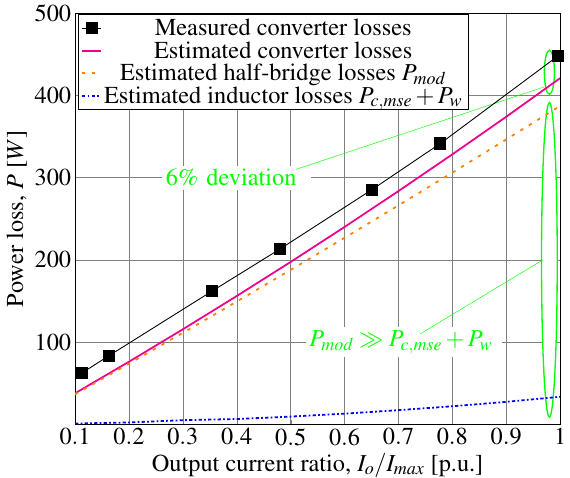
Figure 10. Power loss distribution of the converter for a fixed switching frequency of 20 kHz. It is necessary to ensure an inductance at the maximum current for a specified current ripple for powder core design. The maximum current ripple for this study is approximately 31.2 A with a maximum switching frequency of 20